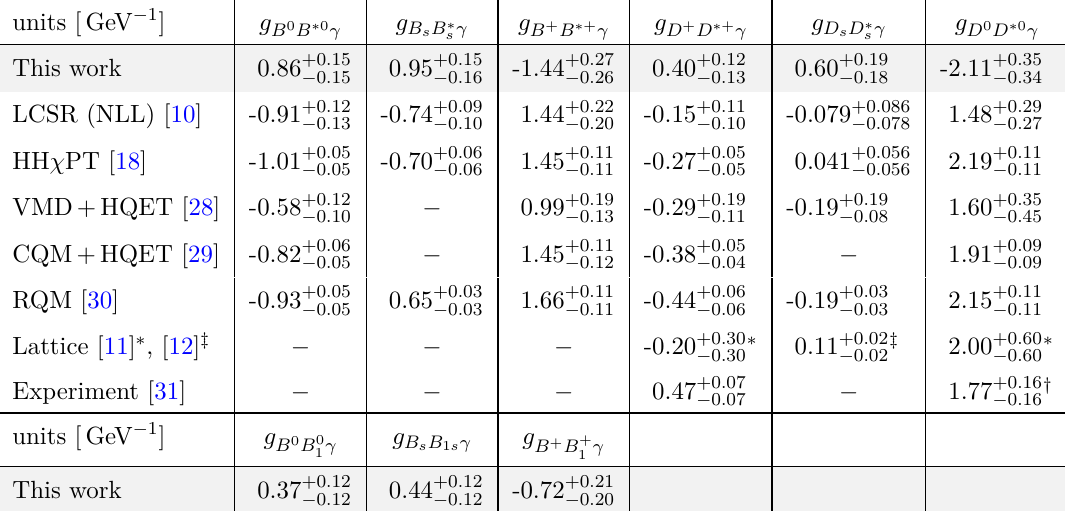
requires the use of isospin symmetry to deduce D 0 D ∗ 0 γ